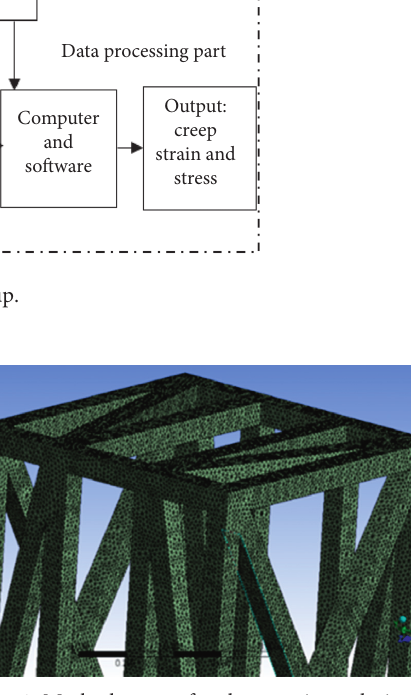
Figure 4: Mesh elements for the test rig